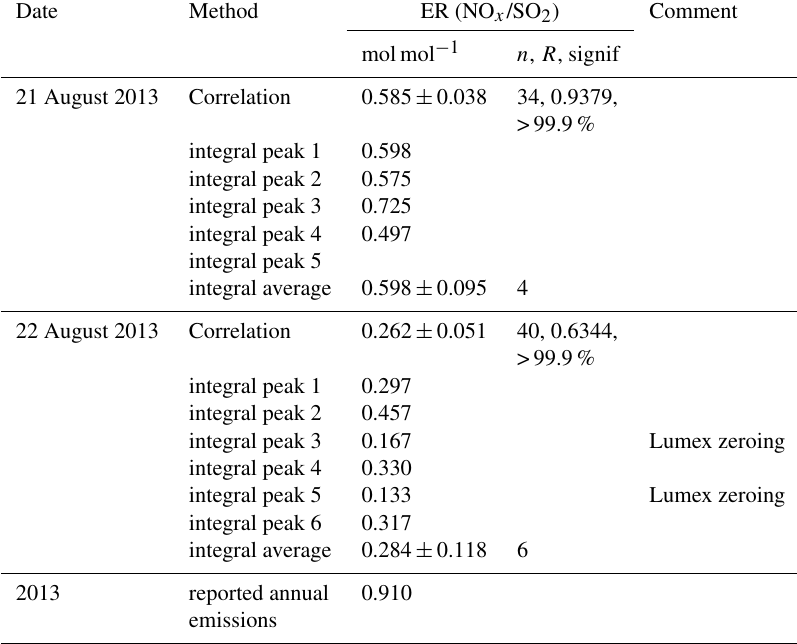
Table 5. O 3 / NO x enhancement ratios (ERs). Correlation method: 10s average O 3 mixing ratios correlated with 10s average SO 2 mixing ratios above 10ppb with uncertainties set to 1ppb for O 3 and 1ppb for NO x . Integral method: 1s O 3 and 1s NO x signals integrated over the duration of the individual plume intersection. Background mixing ratios for O 3 and NO x are 43.09 and 1.78ppb, respectively, for 21 August. Individual O 3 background mixing ratios (average of background before and after the peak) varying between 53.9ppb for peak 1